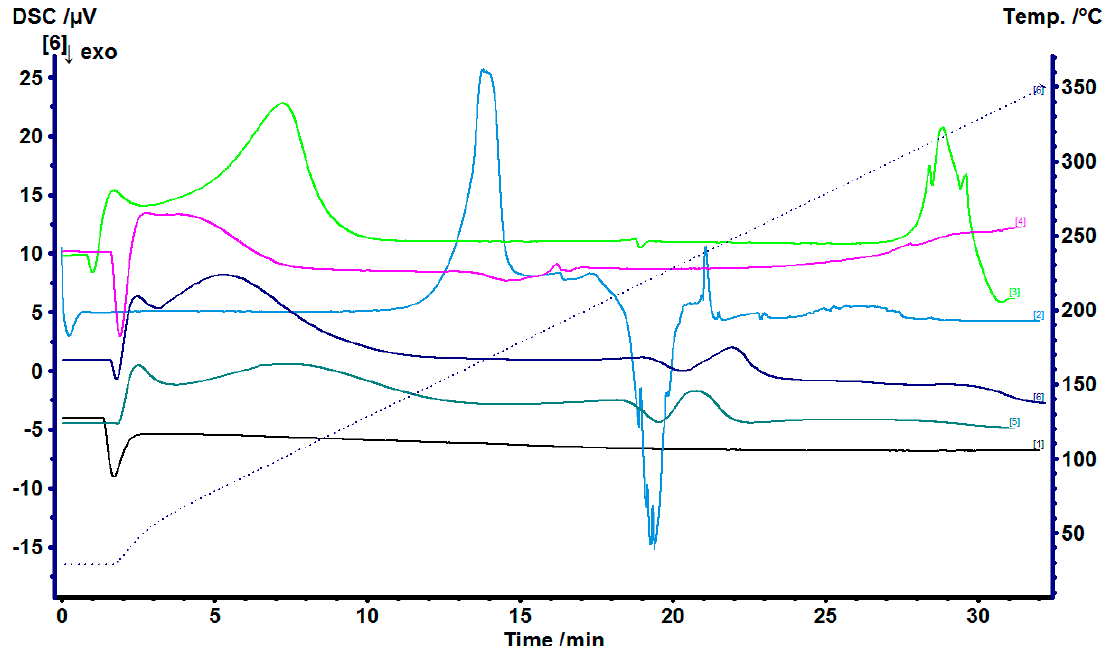
Figure 2. Differential scanning calorimetry (DSC) thermograms of: empty pan—black; pure doxycycline hyclate—light blue; pure β -cyclodextrin—light green; HPMC—pink; doxycycline- β -cyclodextrin (freeze-dried) + HPMC microparticles—green; and doxycycline- β -cyclodextrin in HPMC solution and HPMC microparticles—blue.